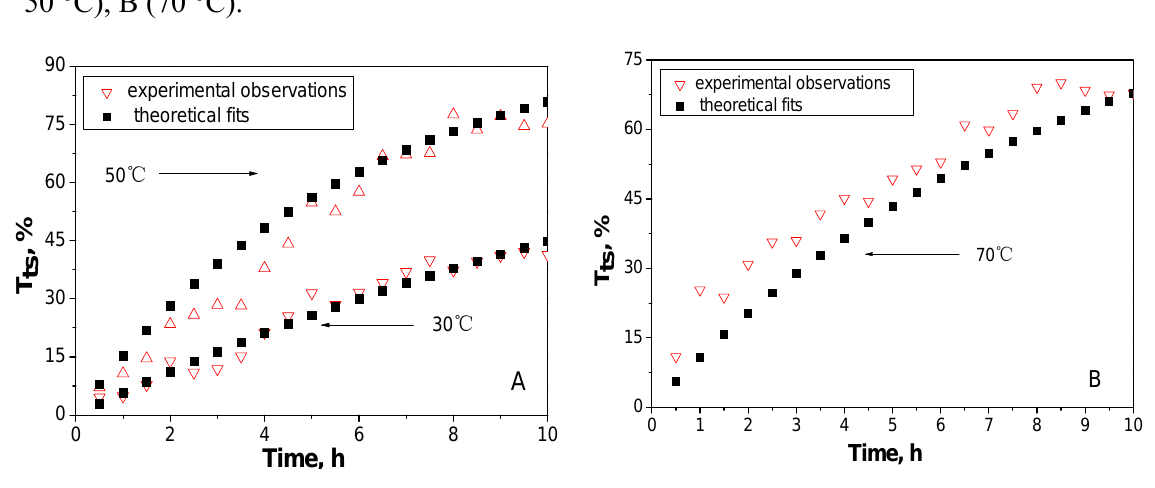
Figure 10. Experimental and mathematical transformation rate points of MCC: A (30 and 50 °C), B (70